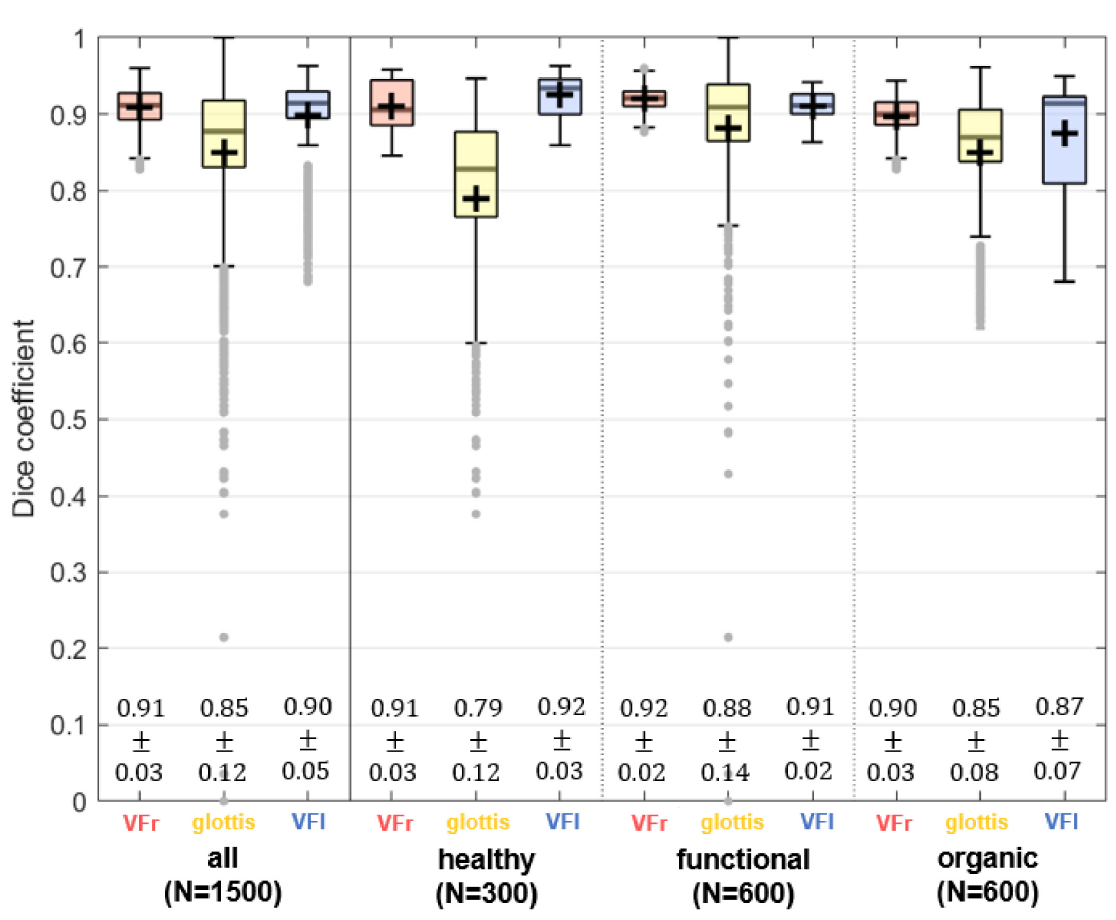
Fig 7. Segmentation accuracy measured by the dice coefficient for the test dataset. Dice Coefficients are individually displayed as boxplots for the classes glottis , left VF , and right VF . Left: Entire dataset. Right: Clinical groups healthy , functional , and organic . The mean values and standard deviations are given